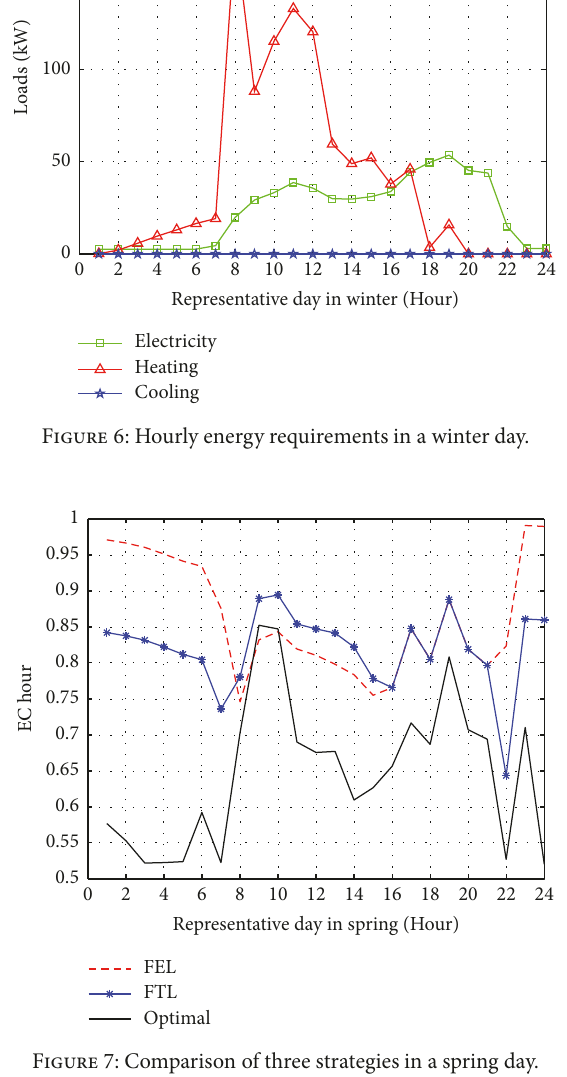
local optimal solution can be avoided and the convergence time is significantly reduced.